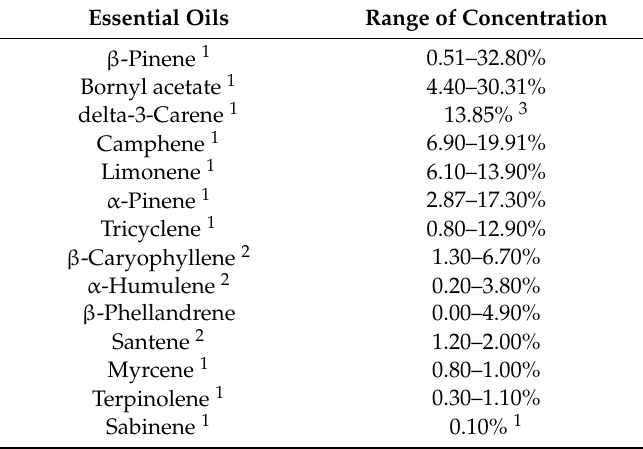
Table A1. Range of concentrations of the main constituents of EOs for needles of silver fir ( Abies alba Mill.), expressed as % w / w of total essential oils (Eos) dry